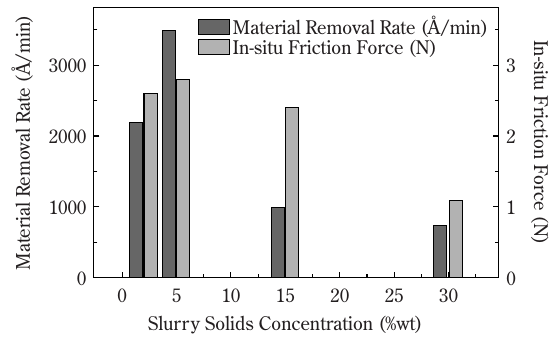
Material removal rate and friction force of silica as a func- tion of solids loading of 0.5 µ m silica abrasives.